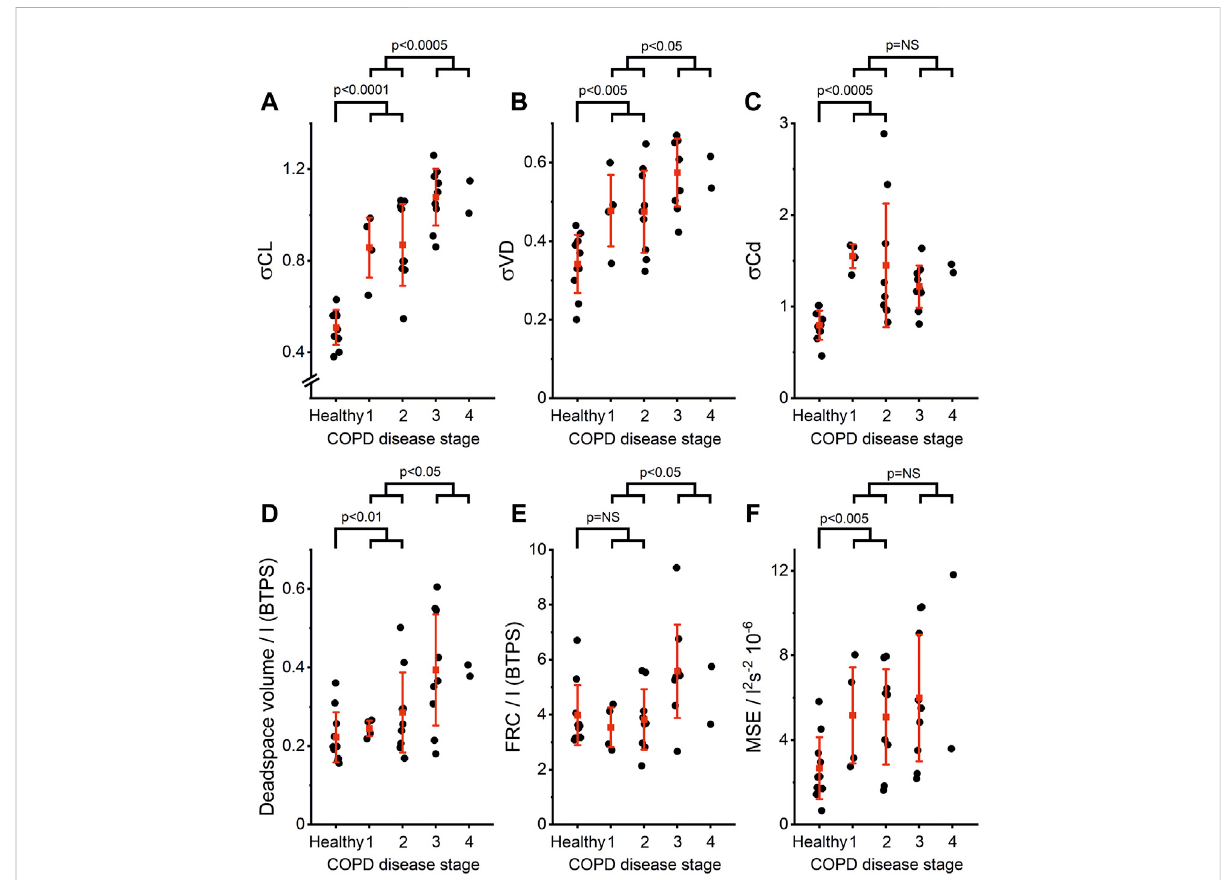
FIGURE 2 Lognormal Lung model parametersfor healthy age-matched controls and COPD patients of increasing GOLD Stage. (A) Standard deviation for the distribution of lung compliance, σ CL, (B) Standard deviation for the distribution of anatomical deadspace, σ VD, (C) Standard deviation for the distributionofvascularconductance, σ Cd, (D) Anatomicaldeadspace volume (E) Functional residualcapacity,FRC, and (F) Meansquared error, MSE. Gold Stages are de fi ned as 1: FEV 1 > 80% predicted; 2: 50% predicted < FEV 1 < 80% predicted; 3: 30% predicted < FEV 1 < 50% predicted; and, 4: FEV 1 < 30%predicted.Dataareshownforindividualsinblack,andstage-by-stageaveragesandstandarddeviationsareshowninred.Groupaverages arenotshownforstage4duetolowgrouppopulation.Signi fi cantdifferenceswereidenti fi edbetweenhealthycontrolsandpatientswithlesssevere obstruction (stages 1 and 2) for σ CL, σ Cd, σ VD, deadspace volume, and MSE. Signi fi cant differences between COPD patients with less severe obstruction (stages 1 and 2) and those with more severe obstruction (stages 3 and 4) were identi fi ed for σ CL, σ VD, deadspace volume, and